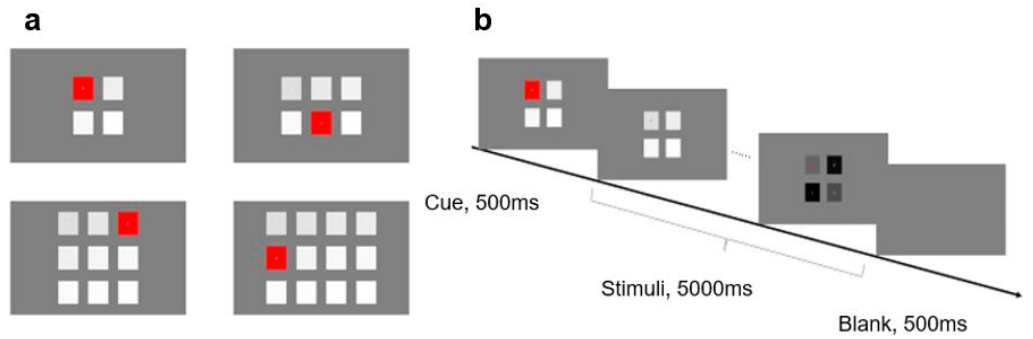
Figure 4. Stimuli and procedure in Experiment 2: ( a ) Four kinds of layout with different numbers of stimuli; and ( b ) an example sequence of displays in a typical trial of Experiment 2.